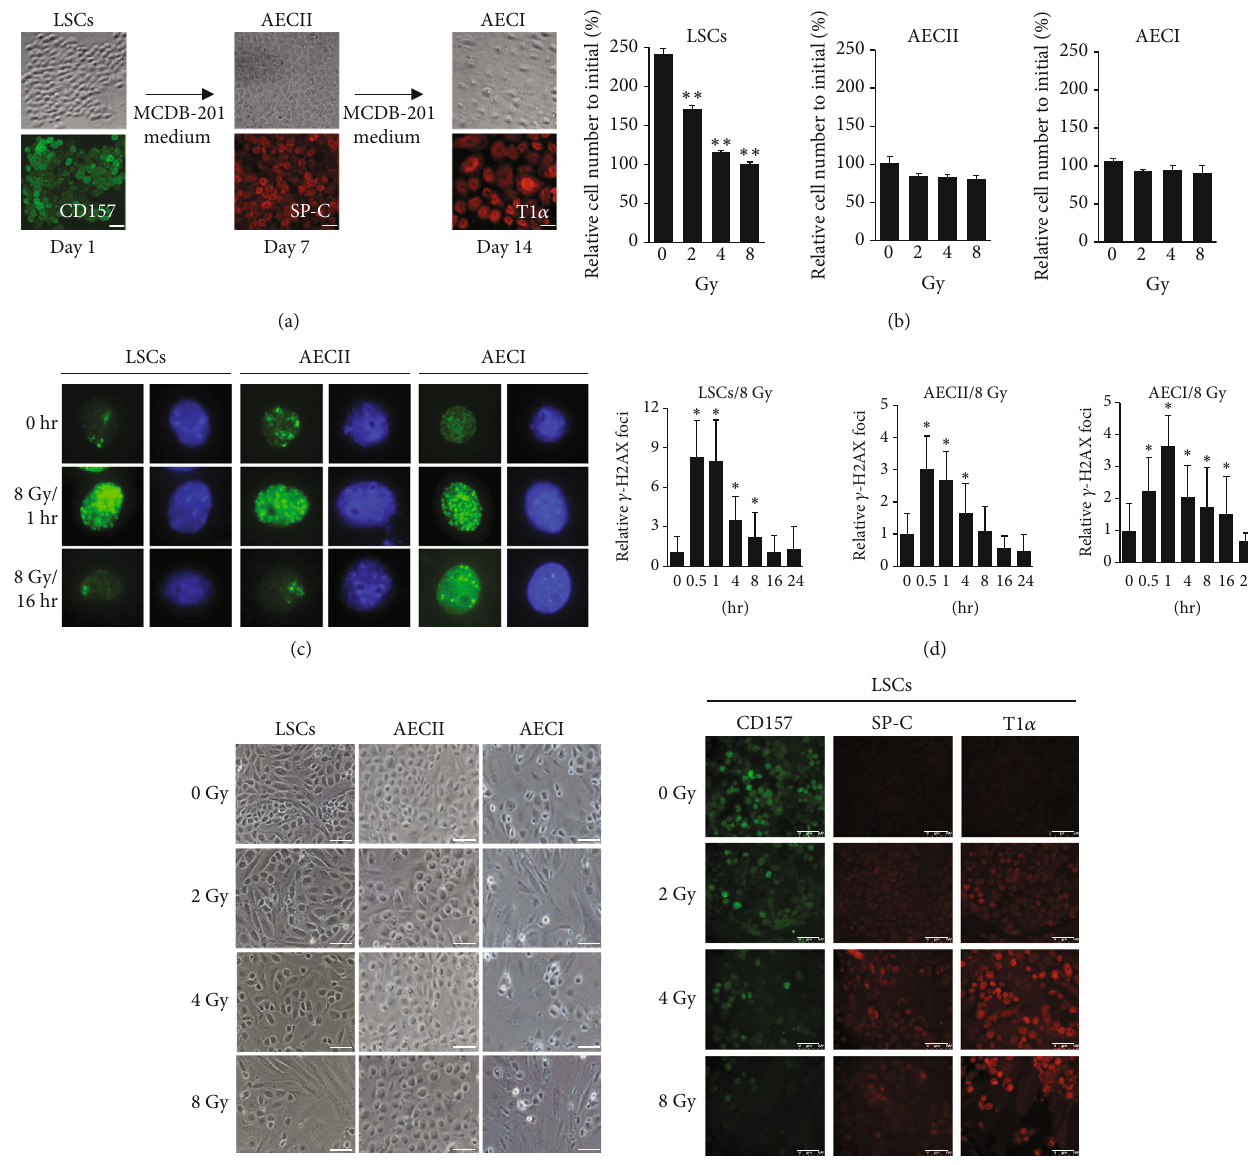
Figure 1: The lung cell di ff erentiation and the e ff ects of radiation exposure on LSCs and alveolar cells. (a) Work fl ow and time line of in vitro lung cell di ff erentiation experiments. LSCs were isolated from neonatal ICR mice and then sequentially di ff erentiated into alveolar cells by culture with MCDB-201 medium. LSCs, AECII, and AECI cells were examined through immunostaining with anti-CD157, anti-pro-SP-C, and anti-T1 α antibodies. Scale bars, 100 μ m. (b) Cell numbers of irradiated LSCs and alveolar cells were examined at day 3 postirradiation. The results are represented as mean ± SD ( n = 3 , ∗ p < 0 : 05 ) relative to initial cell number. (c) Immunostaining of γ -H2AX expression (green, left panels) and nuclear morphology (blue, right panels) in LSCs and alveolar cells that received 8 Gy at 1h and 16h. (d) The lung cells repair radiation-induced DNA double-strand breaks as determined by nuclear foci formation of γ -H2AX. The nuclear γ -H2AX foci per cell are means ± SD from LSCs and AECII cells ( n > 100 ) or AECI cells ( n > 75 ) relative to the initial sample. (e) The cell morphology of irradiated lung cells at day 3 postirradiation. Scale bars, 100 μ m. (f) The cell di ff erentiation of irradiated lung stem cells was examined at day 3 postirradiation by immunostaining with speci fi c protein markers CD157, SP-C, or T1 α . Scale bars, 100 μ